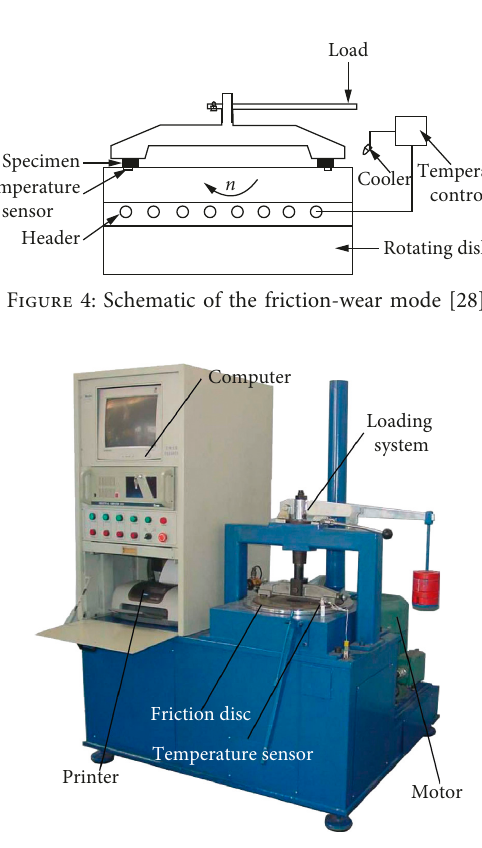
Figure 5: Real photo of the constant-speed